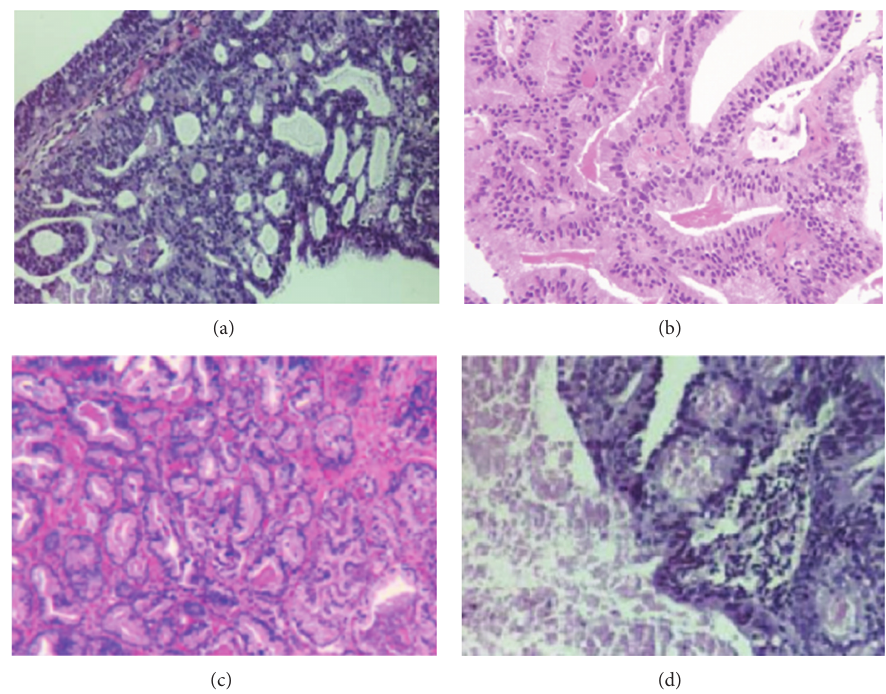
Figure 1: Examples of ductal adenocarcinoma of the prostate. (a) Stain of ductal prostate adenocarcinoma, (b) typical prostatic ductal adenocarcinoma, (c) acinar adenocarcinoma pattern, and (d) ductal adenocarcinoma of the prostate.